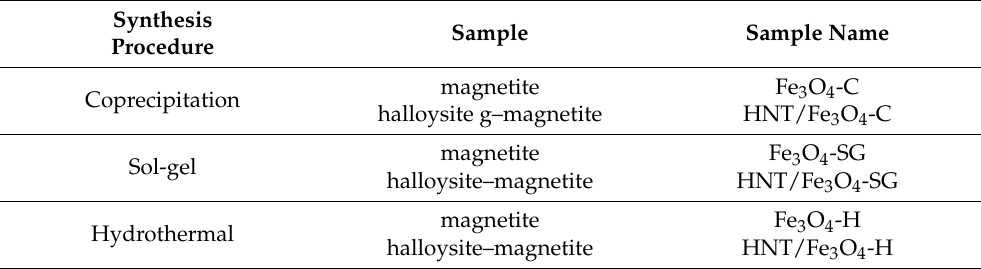
Table 1. Scheme of the synthesis procedures and samples